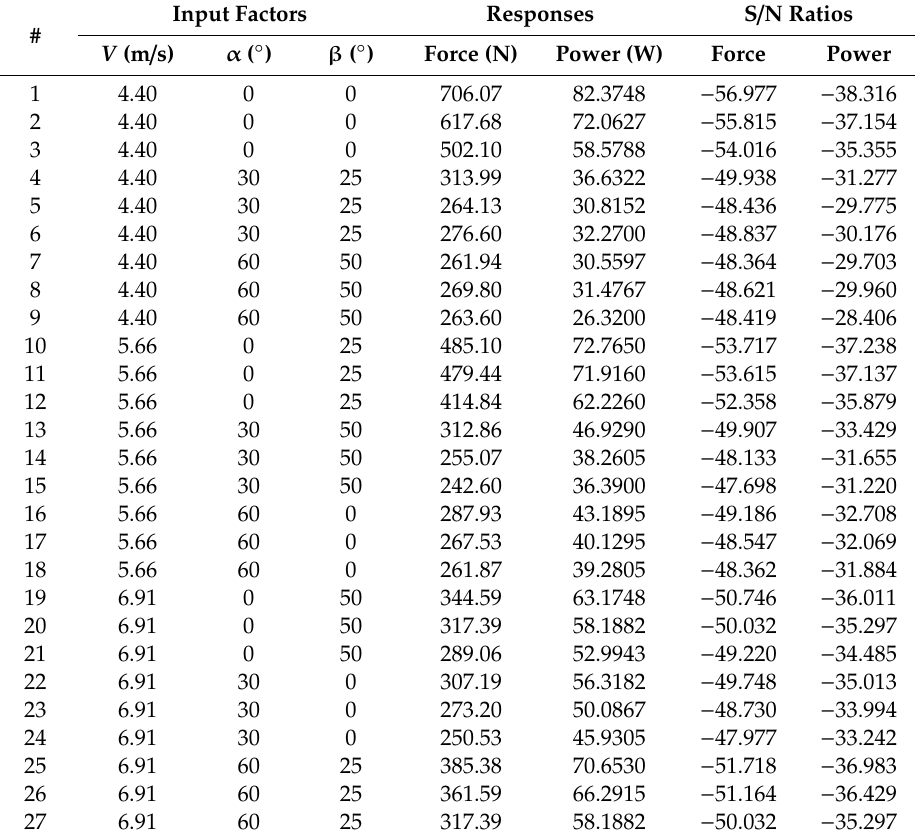
Table 2. The L27 orthogonal array, experimental results and corresponding signal-to-noise (S / N)